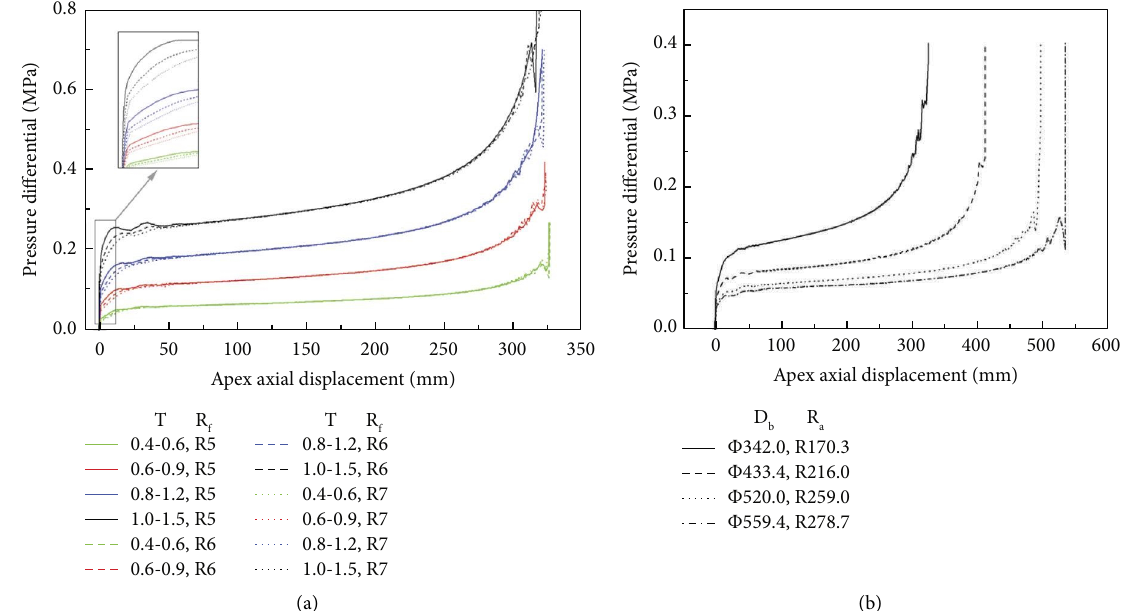
Figure 10: Relationships of pressure diferential and apex axial displacement for the frst group diaphragms (a); the diaphragms with same T and R f (b).